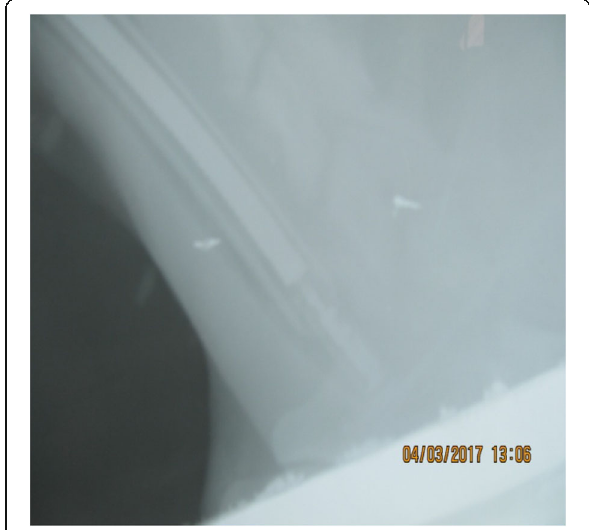
Fig. 5 Lateral cervical radiograph with the endotracheal tube fitted with the semiflexible cold fibre optic probe in the middle of the tracheal lumen